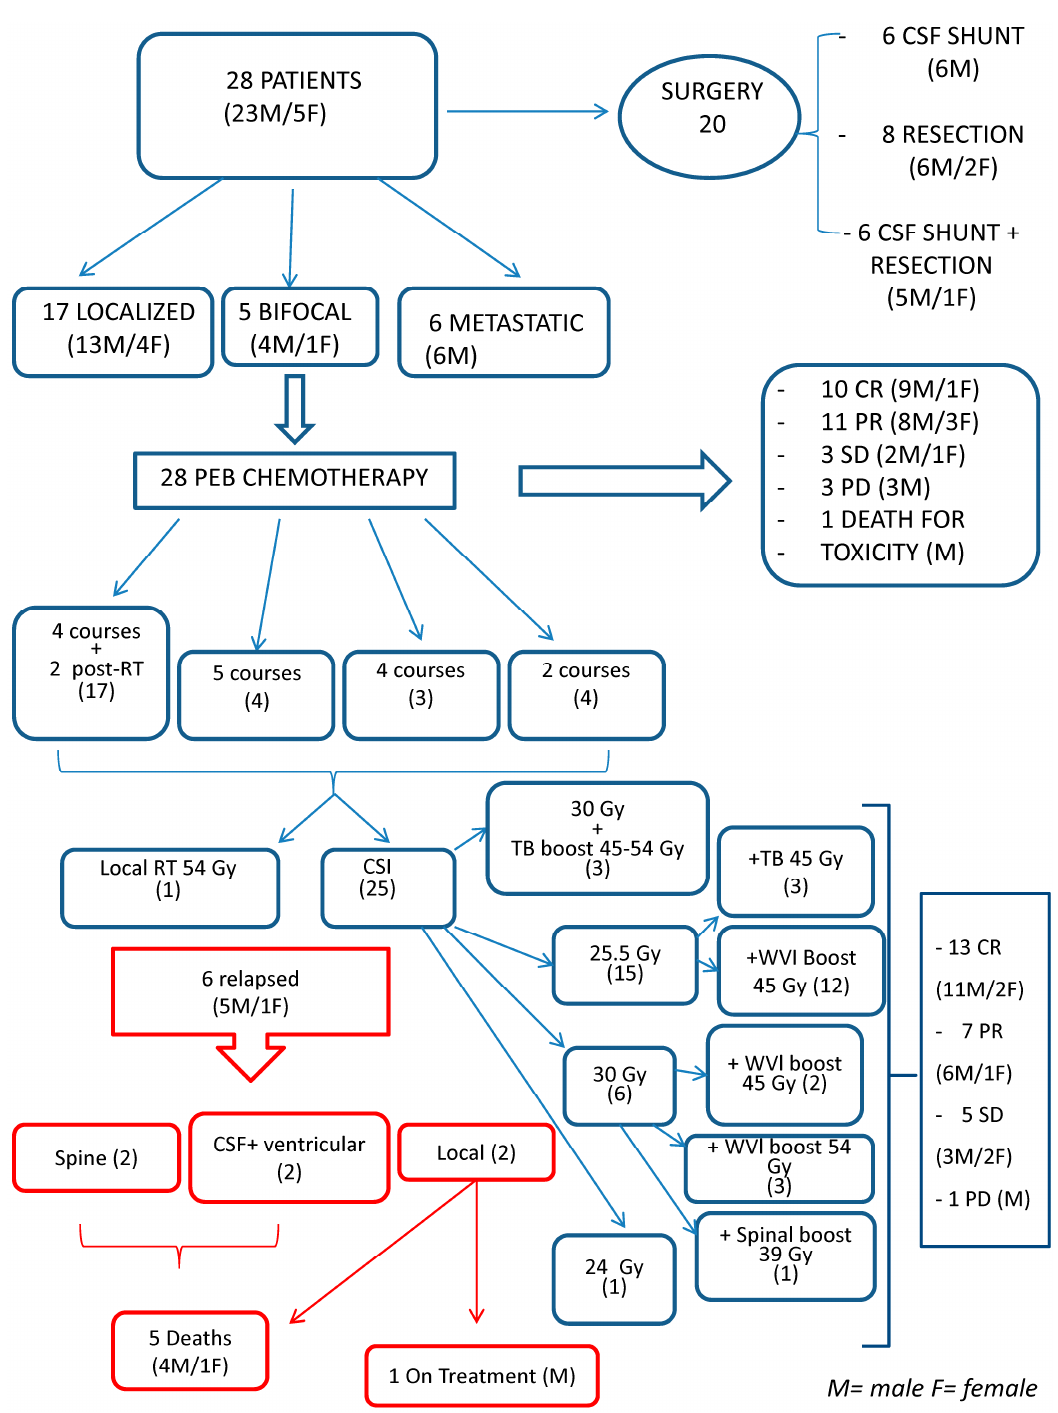
Figure 1. Consort diagram of the whole series.